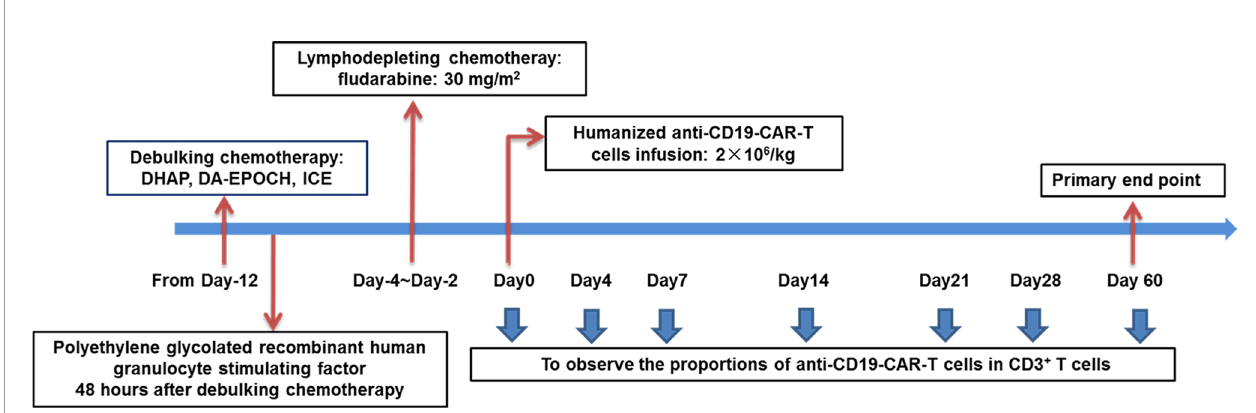
FIGURE 1 | Schematic diagram showing the strategy for the treatment of patients in the combined group. Patients were given debulking chemotherapy and lymphodepleting chemotherapy sequentially, and then received anti-CD19-CAR-T